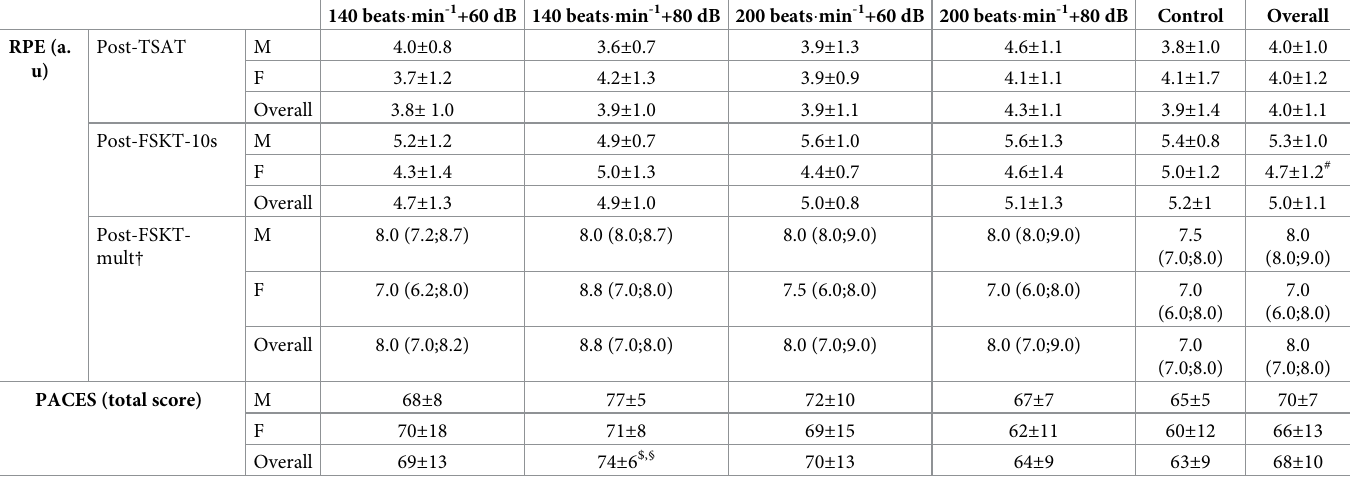
Table 3. Rating of perceived exertion (RPE) and physical enjoyment variations across the different conditions (n = 20).